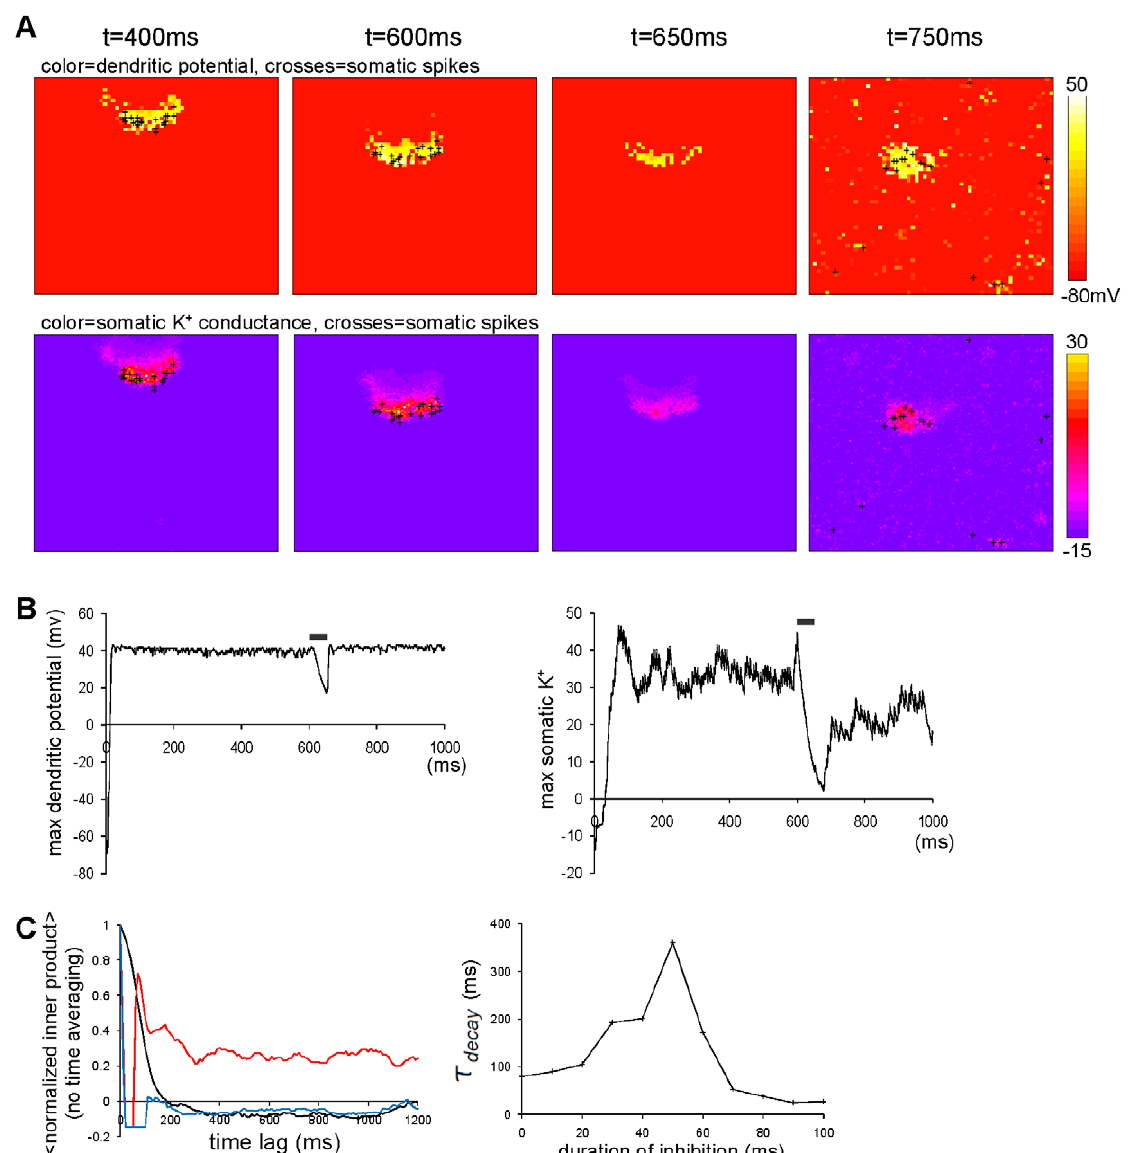
Figure 7. Determinant of inhibitory period for switching a bump from moving to immobile modes. The simulation runs where background inputs changed from noiseless to noisy currents via the varying length of the inhibitory period. The noiseless current is defined solely by the constant part m c onst ~ 7 : 0 pA, while the noisy current is defined solely by the noisy part s noise ~ 22 : 7 pA. t d ~ 200 ms. (A) Snapshots for dendritic potential (upper) and somatic K z activity (lower) in the noiseless condition ( 400 ms), at the switching point between the noiseless condition and inhibition period ( 600 ms), at the switching point between the inhibition period and the noisy condition ( 650 ms), and in the noisy condition ( 750 ms). The meaning of the symbol and color are same as the previous figures. (B) The time courses of maximum values of the dendritic potential (left) and the somatic K z activity (right) in the simulation run the same as (A). The gray bar indicates the inhibition period. Whereas the somatic K z activity substantially drops, the dendritic potential and K z activity are kept at large values. (C) (left) The inner products between the activity at the switching point from the noiseless to inhibitory period ( 600 ms) and the subsequent activities. The durations of inhibitory periods are 0 ms (black), 50 ms (red) and 100 ms (blue). The rapid decline in the black line means that the change from the noiseless to noisy condition without an inhibitory period did not immobilize the bump. The high values maintained in the red line mean that the inhibitory period successfully immobilized the bump, which did not work well when the inhibitory period was too long (blue). Note that each of the curves were obtained by the trial, but not the temporal average of the time lag-dependent inner products, which are denoted by S : T . (right) Dependence of the decay time constant of the inner product on the duration of the inhibitory